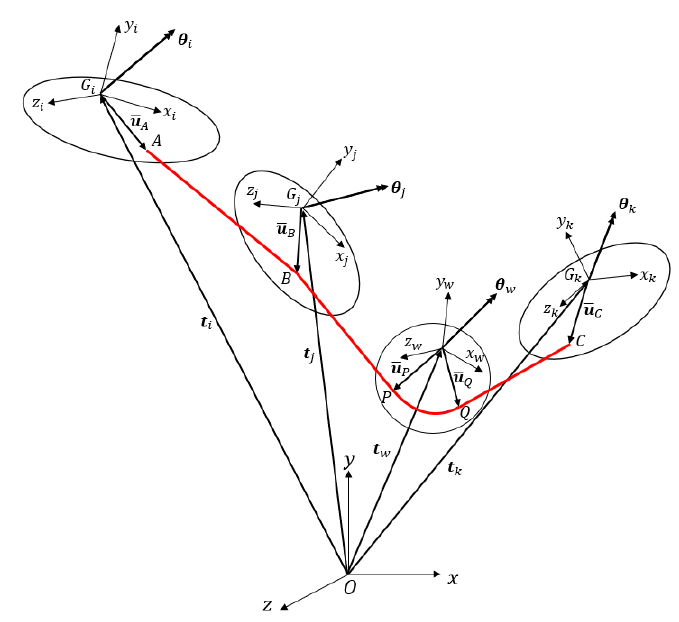
Figure 6. Muscle series.